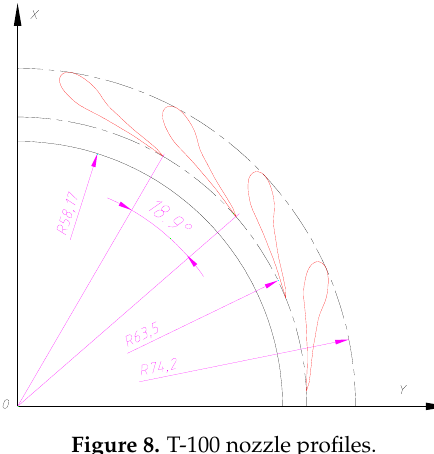
Figure 8. T-100 nozzle profiles.